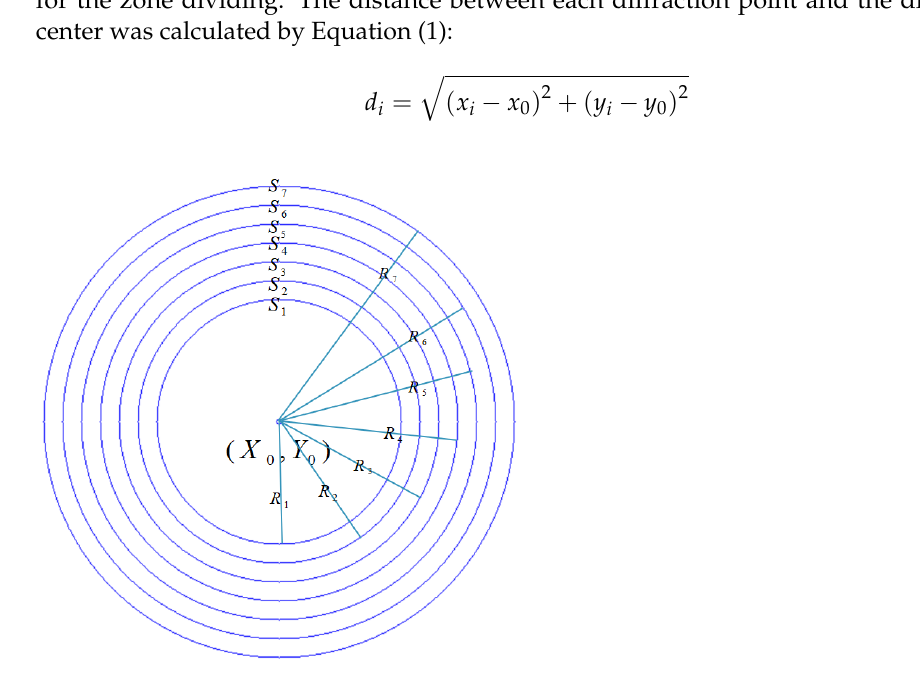
Figure 10. Density model illustrated by dividing concentric circles for the ratio of diffraction zone calculation (7-circle mode, as shown in Figure 4c).